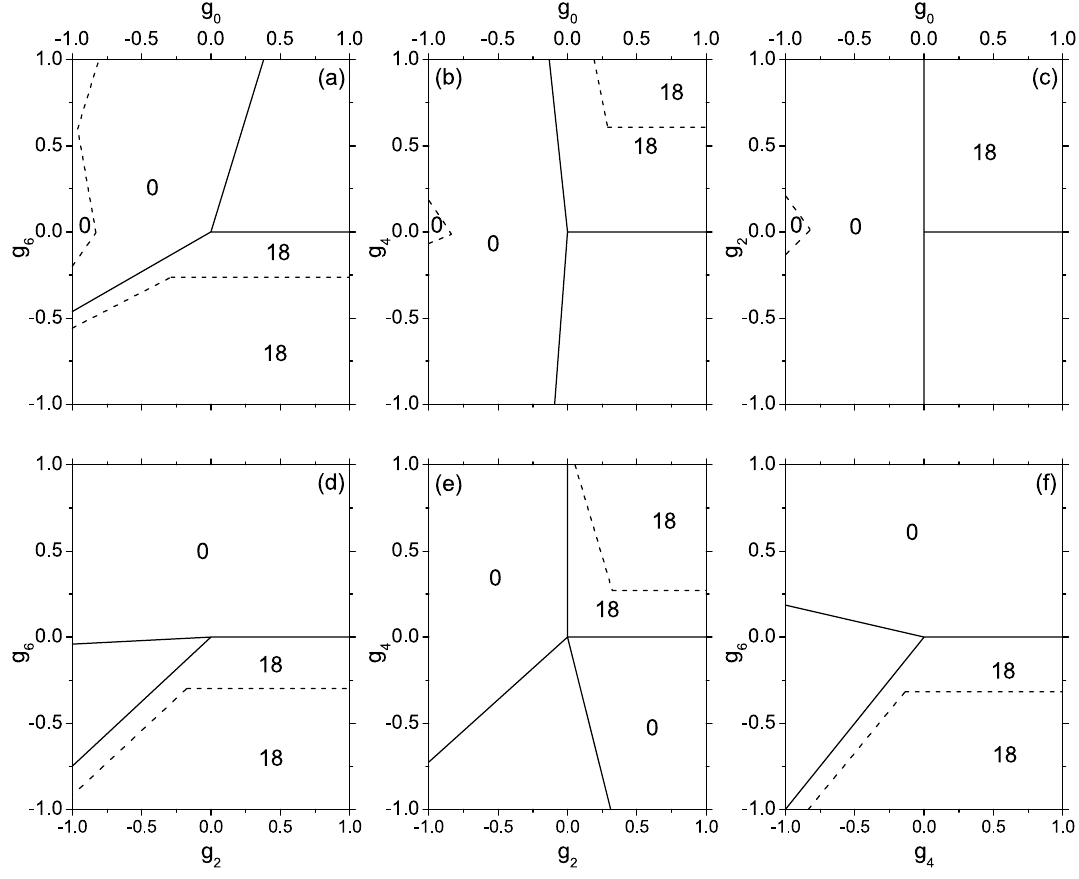
Figure 2. The phase diagrams for N = 6 systems (refer to Fig. 1). Only the zones with S = 0 and 18 are